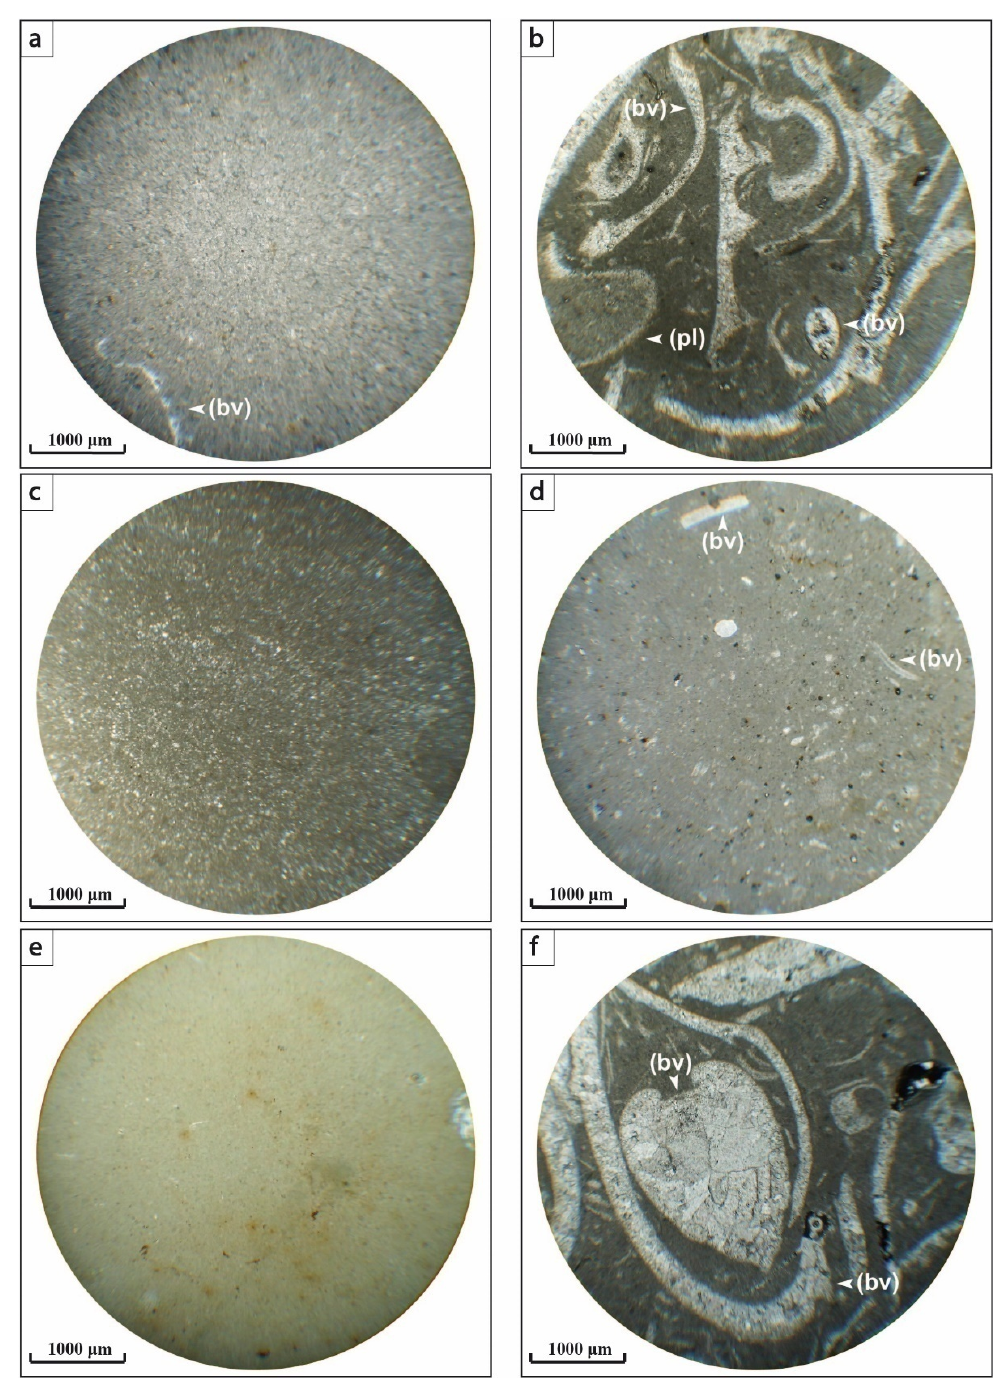
Figure 10. Thin section photographs of microfacies of the Akrabou Formation in the Foum El Kouss section. ( a ) mudstone with rare bivalve shell bioclasts (bv); ( b ) packstone containing bivalve shells (bv) and peloids (pl); ( c ) mudstone with fine micrite and some small patches of recrystallization; ( d ) mudstone shows bioclasts of bivalve shells (bv); ( e ) mudstone with very fine micrite; ( f ) micrite (wackestone/packstone) with bivalve shells (bv).